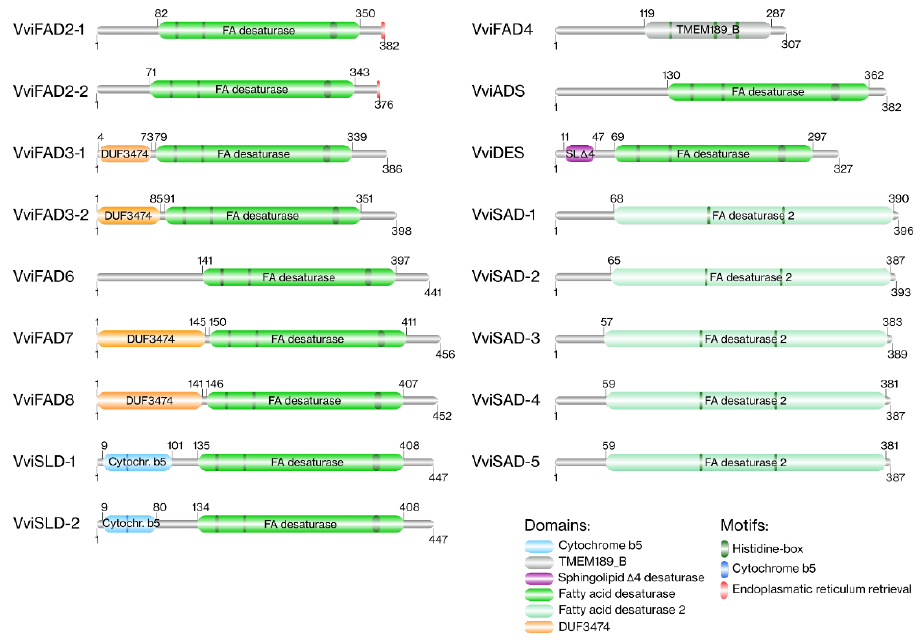
Figure 4. Protein domains and motifs of the grapevine FA desaturases.